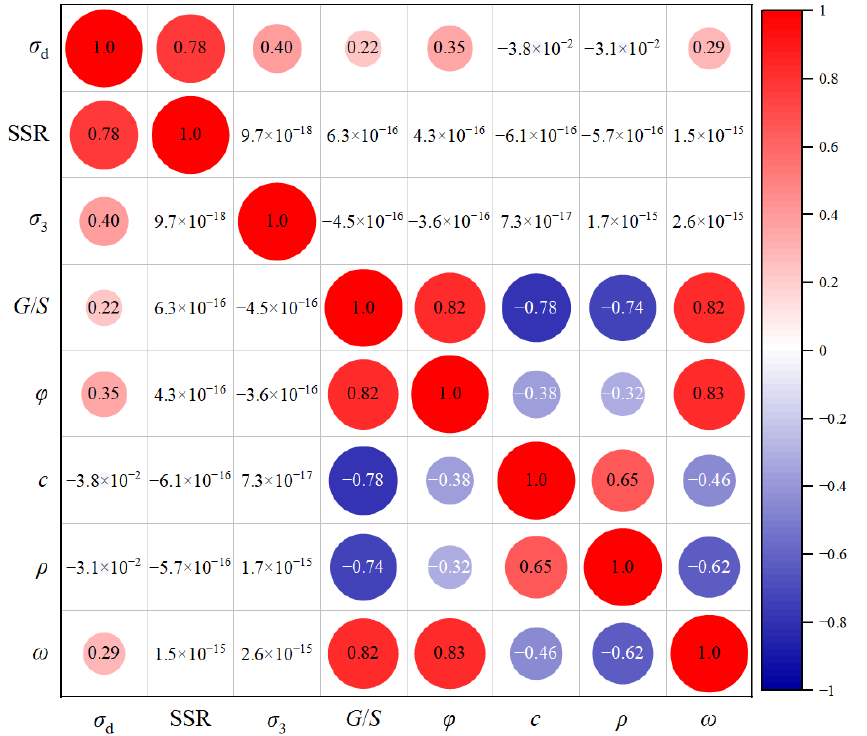
Figure 11. The correlation plot for different input variables.